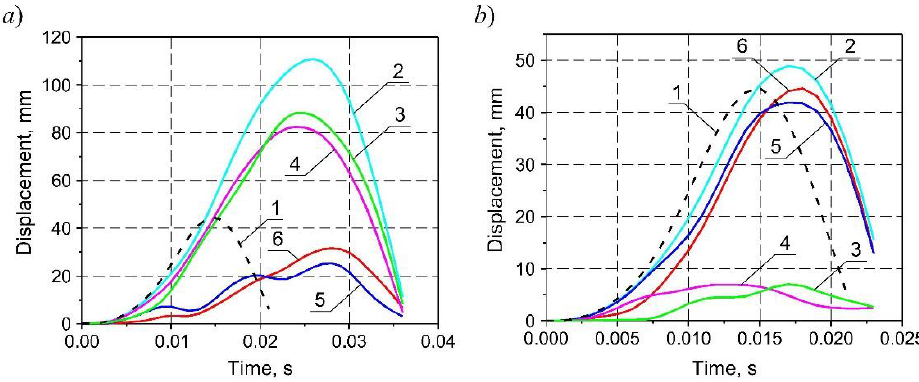
Fig. 6. Change of displacements of reinforced concrete slabs on rigid and yielding supports deformed 4 g g  ): a – for 10000 kN/m/m g  ; b – for in elasto-plastic phase over time ( 1 2 el el 1 el 200000 kN/m/m g  ; 1 – displacements in the center of the slab on rigid supports; 2 – full 1 el displacements in the center of the slab on yielding supports; 3 – displacement of support (node 16 fig. 2, a ); 4 – displacement of support (node 311 fig. 2, a ); 5 –maximum displacement of the slab in section 1-1 without considering deformation of supports; 6 – maximum displacement of the slab in section 2-2 without considering deformation of